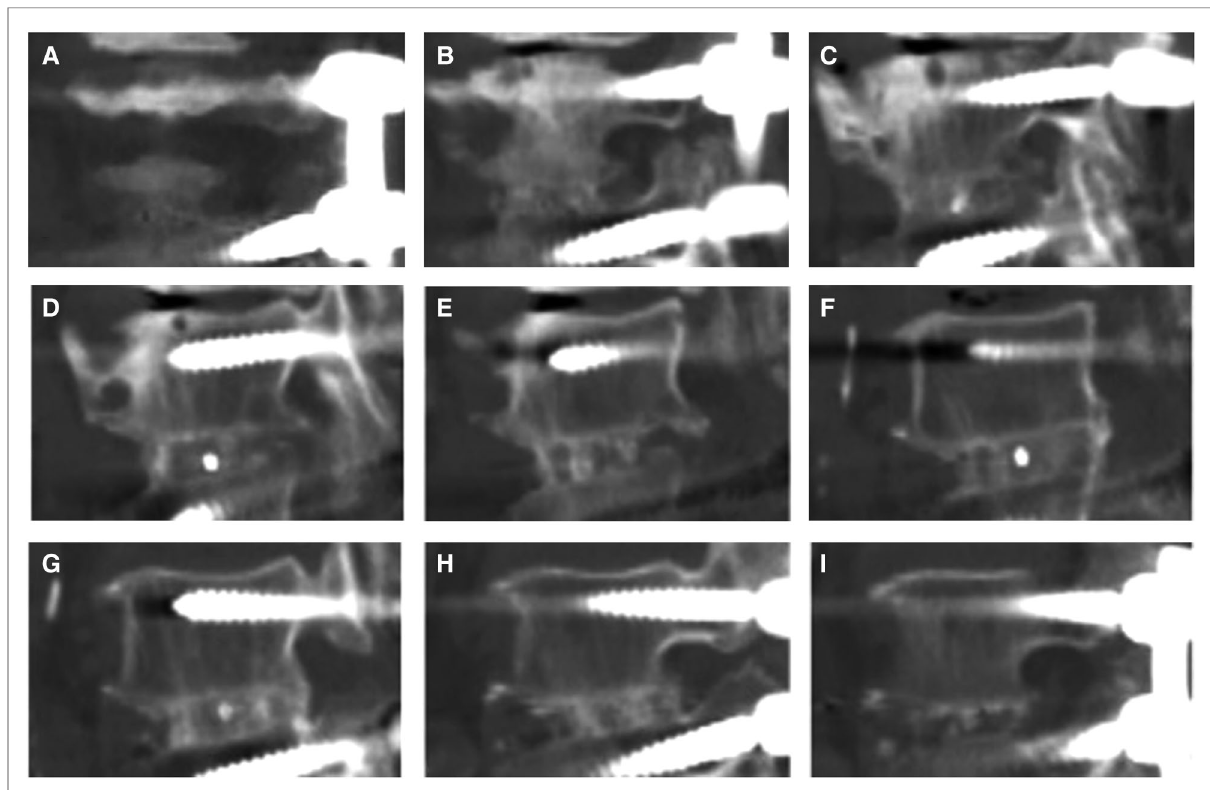
FIGURE 3 For lumbar 4-5 TLIF, the decompression side is on the left, and 2D CT reconstruction in our hospital was scanned from right to left. From ( A – C ), the opposite side of decompression was observed continuously from the fi rst image until the appearance of the cage marker. ( D – F ) is the front, inside and back areas of the cage, and the marker was observe from one side of the cage to the other side. ( G – I ) showed the decompression area, and the last image was observed after the marker on the other side of cage disappeared.